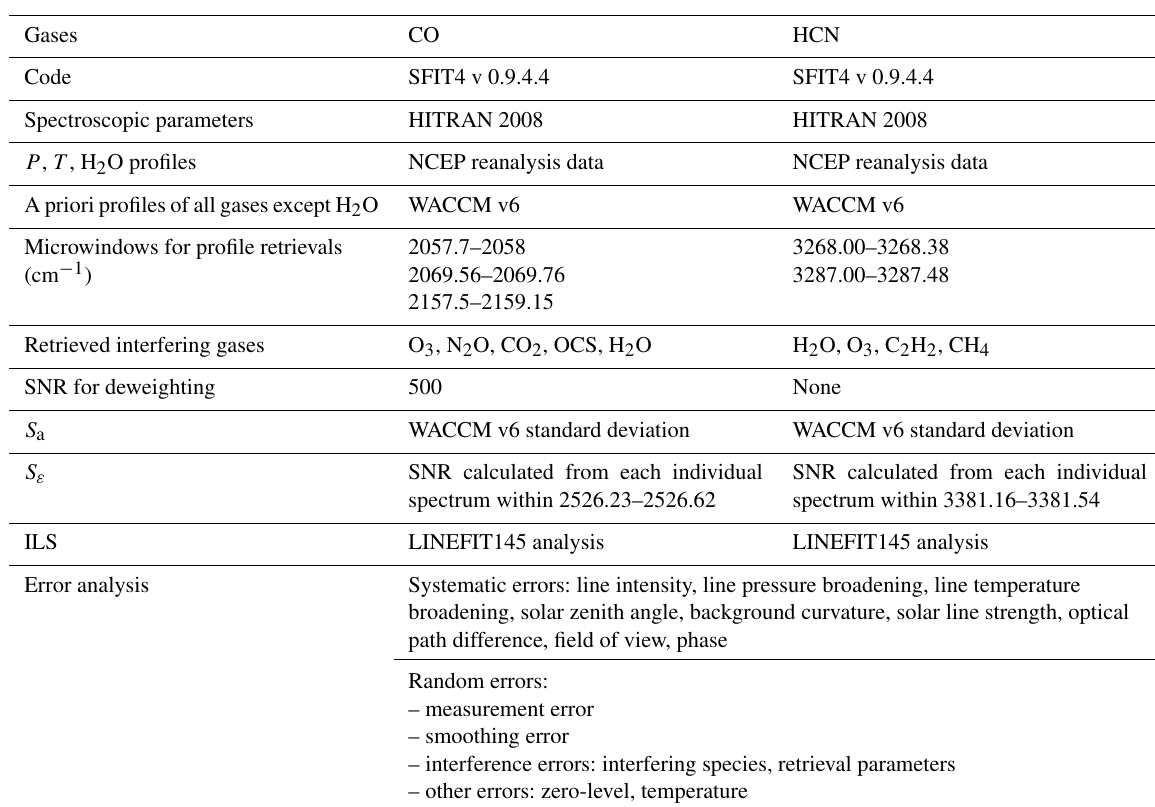
Table 1. Retrieval inputs used for CO and HCN.